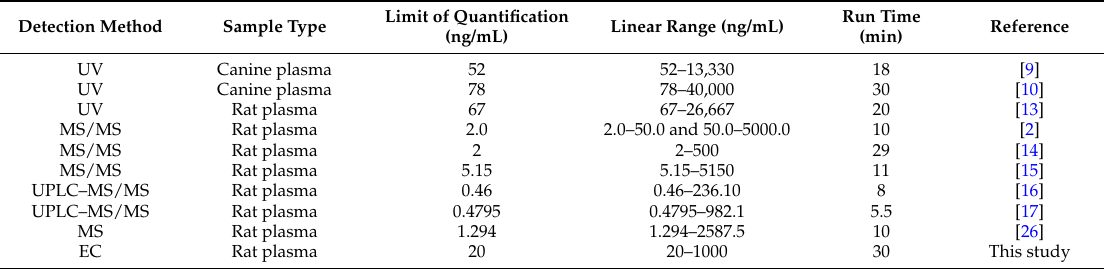
Table 7. Comparison of HPLC-based analytical method performance for